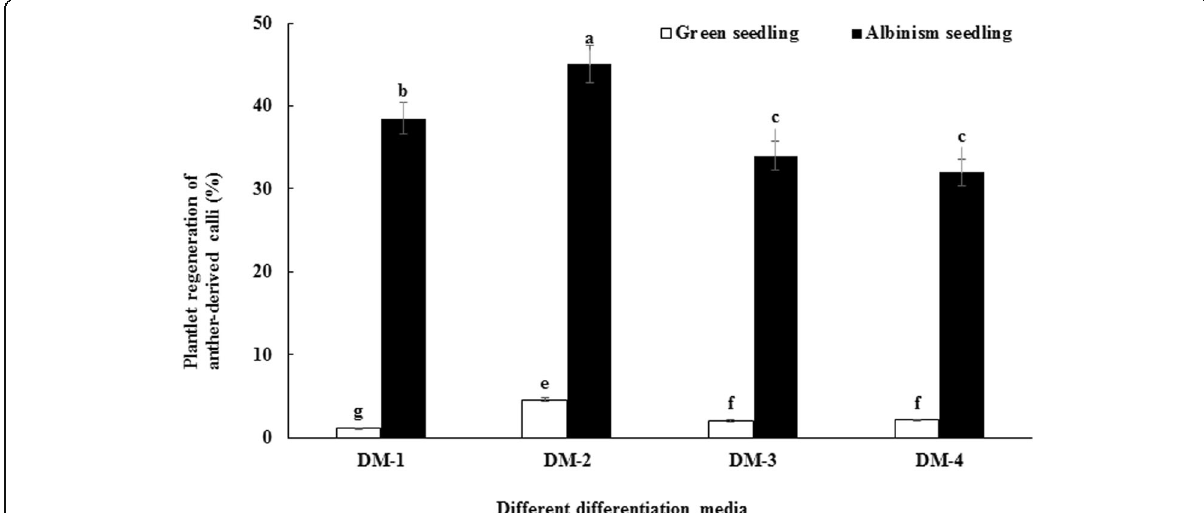
Fig. 1 Effect of phytohormone components on callus differentiation rate. MS was the basic medium (Murashige & Skoog 1962): sucrose 30 g (cid:129) L − 1 and agar 8 g (cid:129) L − 1 . DM-1: 2 mg (cid:129) L − 1 KT and 2 mg (cid:129) L − 1 ABA; DM-2: 2 mg (cid:129) L − 1 KT and 3 mg (cid:129) L − 1 ABA; DM-3: 0.2 mg (cid:129) L − 1 2,4-D, 2.5 mg (cid:129) L − 1 KT, and 2 mg (cid:129) L − 1 ABA; DM-4: 0.5 mg (cid:129) L − 1 2,4-D, 2 mg (cid:129) L − 1 KT, and 2 mg (cid:129) L − 1 ABA. 2,4-D, 2,4-dichlorophenoxyacetic acid; NAA, 1-